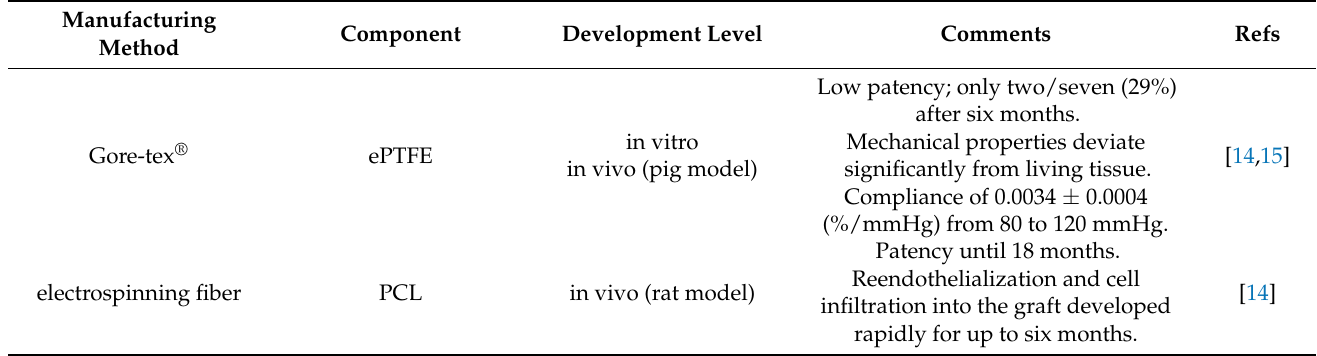
Table 1. Studies of vascular grafts for achieving good mechanical properties and